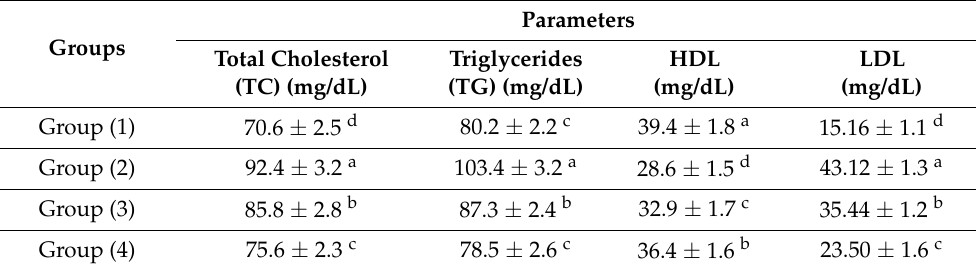
Table 5. Effect of fermented camel milk containing pumpkin seed milk on the lipid profile of experimental